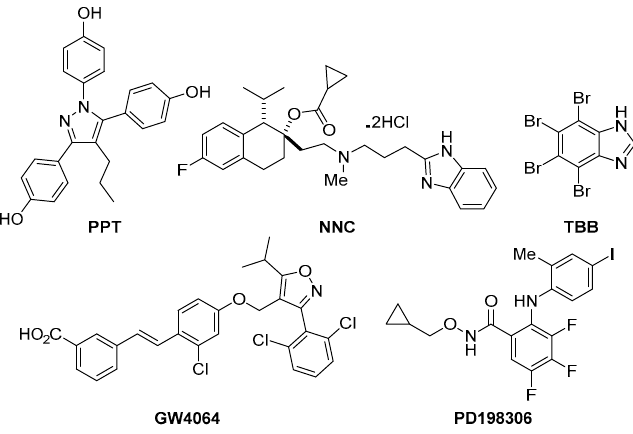
Figure 1. Chemical structures of PPT, NNC, TBB, GW4064, and PD198306.